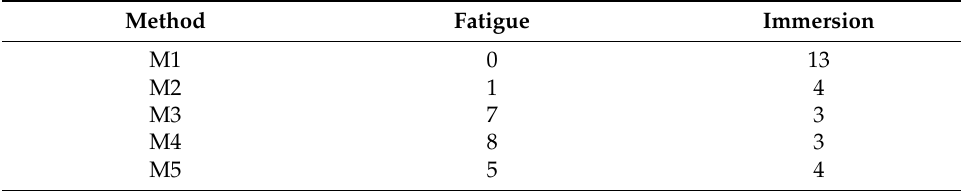
Table 4. The questionnaire results for fatigue and